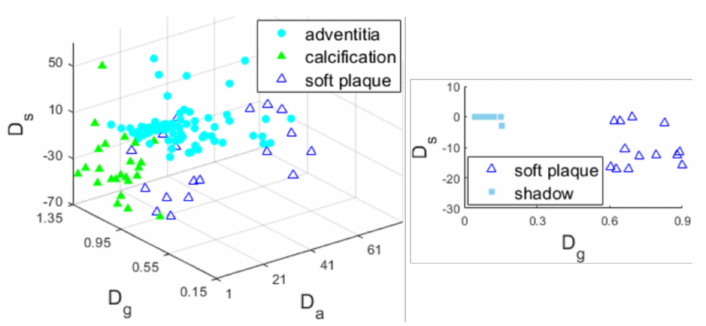
Figure 10. Plots of the indicators and attributions of ROIs when θ adven ≤ T θ ( left ) and θ adven > T θ ( right